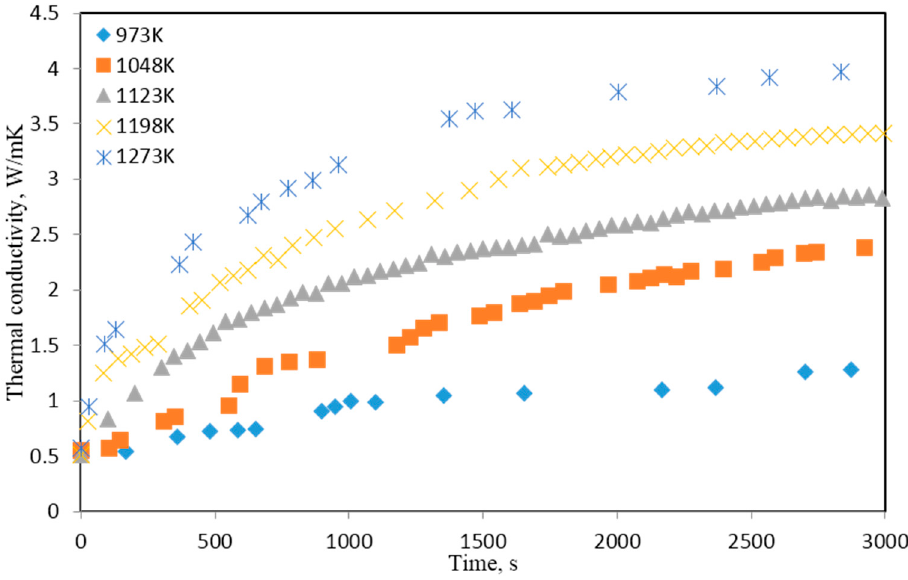
Figure 18. Effect of reaction progress on the effective thermal conductivity values of pressed NiWO 4 .